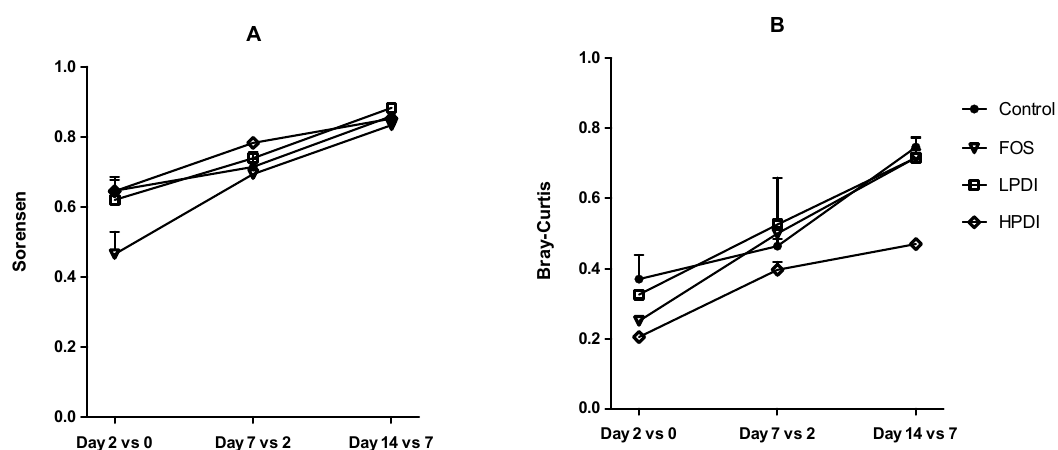
Figure 3. Composition stability, measured as the similarity at the genus level between contiguous sampling days, according to: ( A ) the Sorensen index; and ( B ) the Bray–Curtis index.